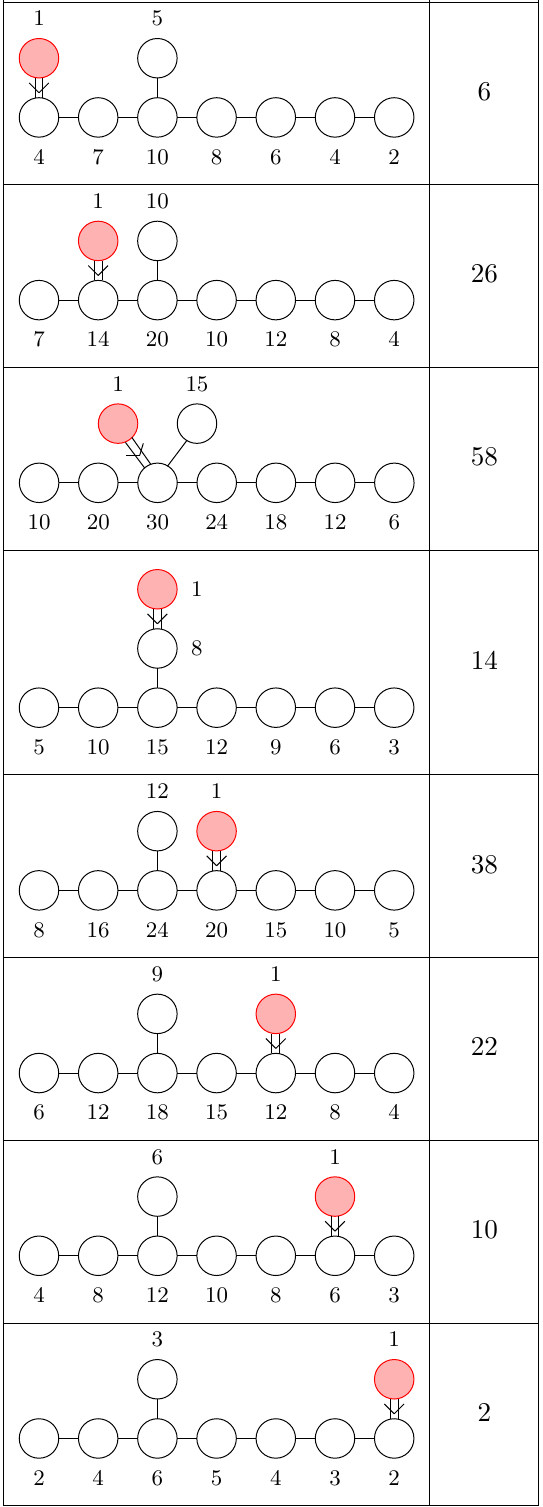
Table 24 . Exotic minimally unbalanced quivers of E 8 -type with outward double laced